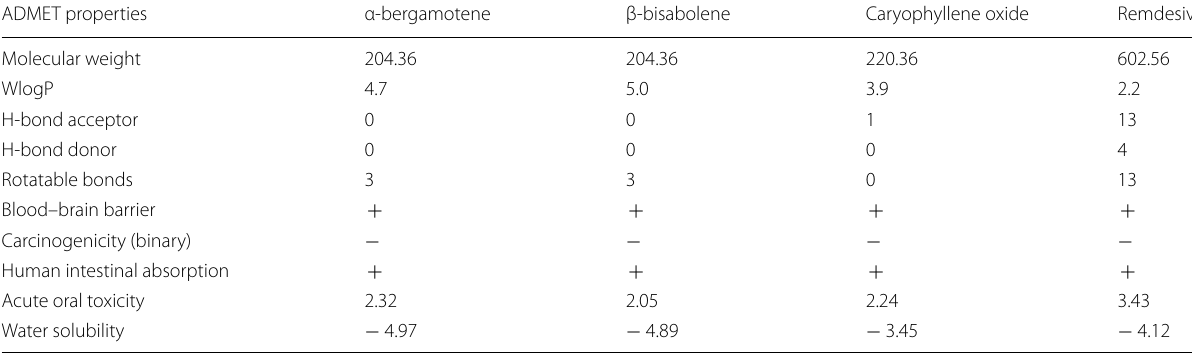
Table 3 ADMET properties of α-bergamotene, β-bisabolene, and Caryophyllene oxide relative to Remdesivir ADMET